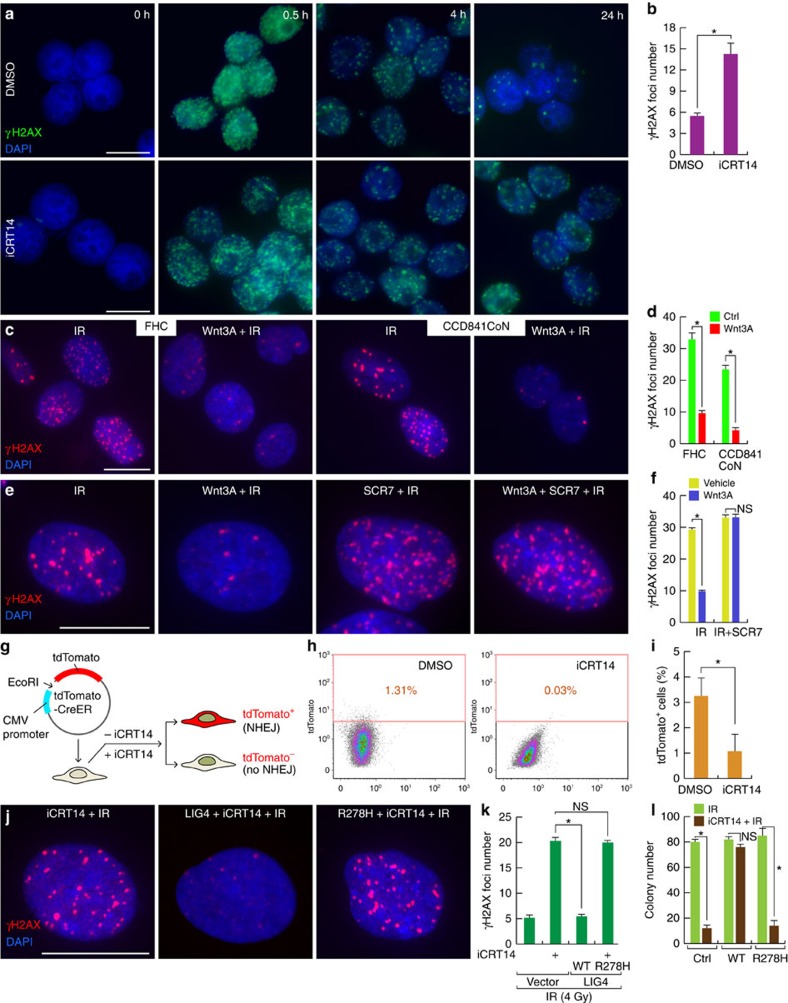
LIG4 mediates Wnt signalling-induced radioresistance.(a,b) Increase of unrepaired DNA damage by Wnt signalling inhibition. HCT116 cells were pretreated with dimethylsulfoxide (DMSO; vehicle control) or iCRT14 (50μM for 24h) and were treated with IR (4 Gy). At each time point, cells were collected for IF staining for phospho-γH2AX (A); quantitative analysis of DNA damage foci (b). Student's t-test; N=3; *P<0.05; error bars=±s.e.m.; scale bars=20μm. (c,d) Decreased DNA damage foci formation by Wnt signalling. Human IECs (FHC and CCD841CoN) were pretreated with Wnt3A (200 ng ml−1 for 24 h) and were subjected to IR (4 Gy). After 24 h, cells were analysed for DNA damage foci formation. IF staining (c); quantitative analysis (d). Student's t-test; N=3; *P<0.05; error bars=±s.e.m.; scale bars=20μm. (e,f) Inhibition of LIG4 blocks Wnt3A-induced radioresistance. CCD841CoN IECs were pretreated with Wnt3A (200 ng ml−1 for 24 h) and subjected to IR (4 Gy) in the absence or presence of SCR7 (10 μM); quantitative analysis (f). Student's t-test; N=3; *P<0.05; error bars=±s.e.m.; scale bars=20μm. (g–i) Reduced NHEJ activity after Wnt signalling inhibition. SW620-7TGP GFPHigh cells were co-transfected with linearized tdTomato-expressing plasmids (g) CMV, cytomegalovirus. Twenty-four hours after transfection, cells were analysed by FACS (h) and were quantified (i). Student's t-test; N=3; *P<0.05; NS (not significant, P≥0.05); error bars=±s.e.m. (j–l) LIG4 expression rescues Wnt signalling inhibition-induced radiosensitization. iCRT14-treated HCT116 cells (control: empty vector; stably expressing wild-type (WT) LIG4 or R278H mutant LIG4) were exposed to IR (4 Gy). After 24 h, cells were analysed for γH2AX foci formation; IF staining (j), statistical analysis (k) and crystal violet staining (14 days) (l). Student's t-test; N=3; *P<0.05; NS (not significant, P≥0.05); error bars=±s.e.m.; scale bars=20μm. For b,d,f and k, the number of phospho-γH2AX foci were counted in more than 20 nuclei from the three biological replicas.